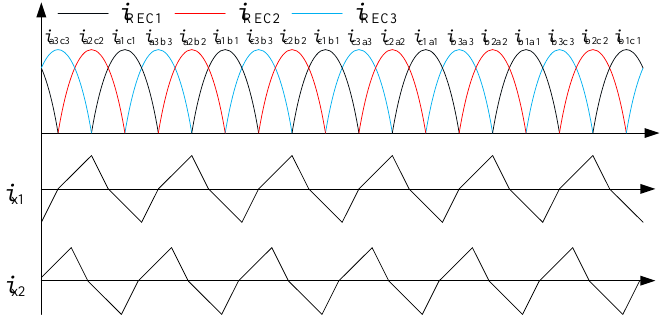
Figure 3. Operating waveforms of the converter. According to Figure 1, when the input voltage of the converter is harmonic-free, and Equation (4) is calculated as follows.